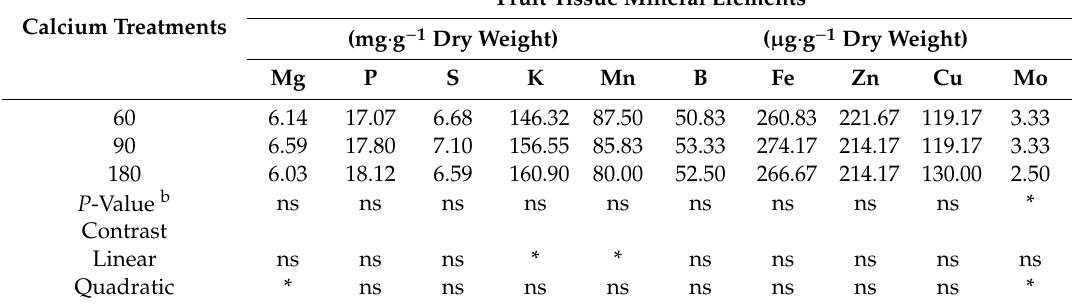
Table 6. Mineral nutrients in fruit tissue of ‘Mt. Fresh Plus’ tomato plants grown in a greenhouse and treated with increasing concentrations of calcium, given as calcium nitrate. Fruit tissue was harvested at 84 d after seeding from the second cluster at the red ripe stage for each treatment and replication for mineral nutrient analysis. Fruit Tissue Mineral Elements Calcium Treatments